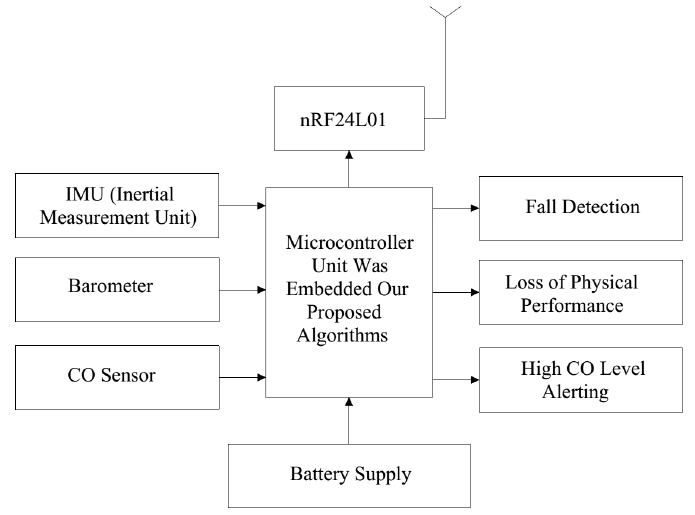
Figure 2. Block diagram of the proposed system.